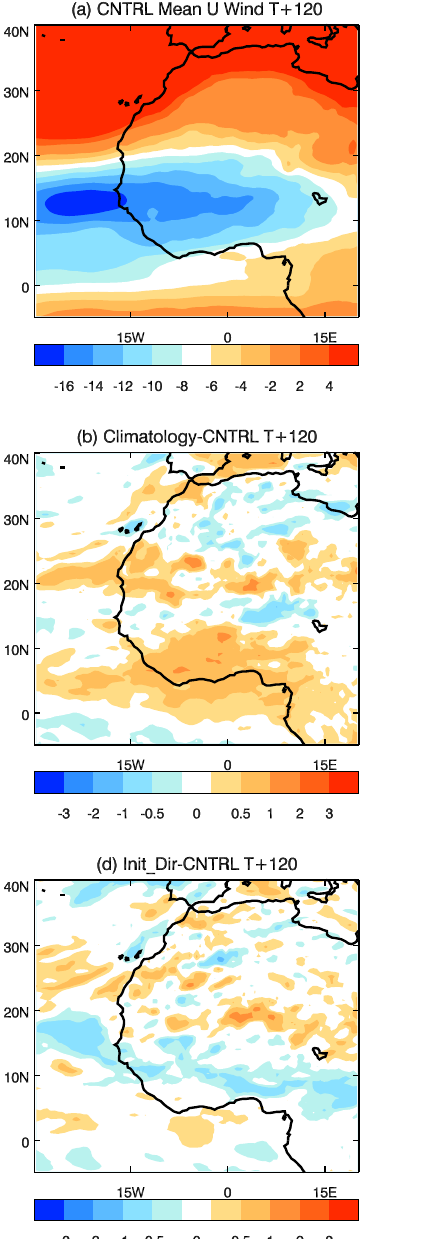
Fig. 20. Impact on 600hPa zonal wind over West Africa at T + 120: (a) CNTRL U wind, (b) CNTRL error, (c) CLIM-CNTRL, (d) AER_DIR-CNTRL, (e) INIT DIR-CNRTL.